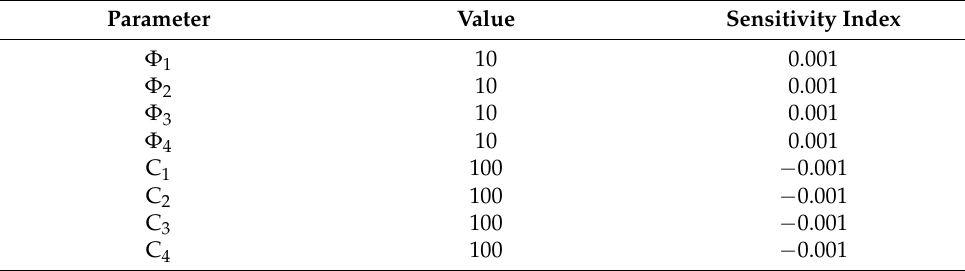
Table 2. Sensitivity indices of R 0 corresponding to all parameters.